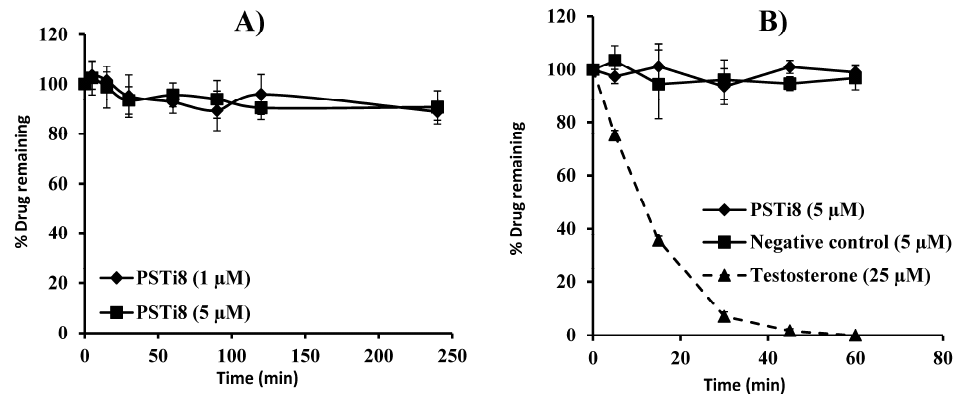
Figure 1. Stability of PSTi8 peptide in ( A ) rat plasma and ( B ) rat liver microsomes. Data are represented in n = 3 with a mean ± SD.